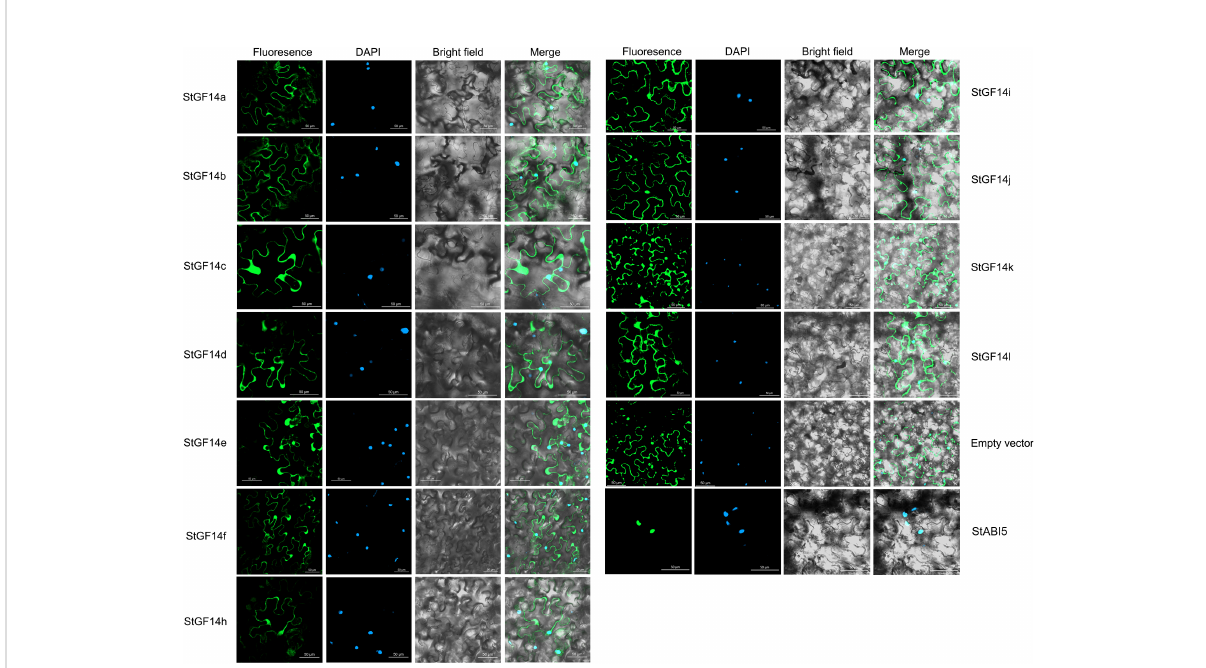
FIGURE 7 Subcellular localization analysis of potato 14-3-3s. Fusion vectors of each potato 14-3-3s and StABI5 are transiently expressed under control of the CaMV35S promoter in tobacco leaves and observed under a laser scanning confocal microscope. The green reprents the GFP signal, and blue represents the nucleus are stained by dapi Bars = 50 m